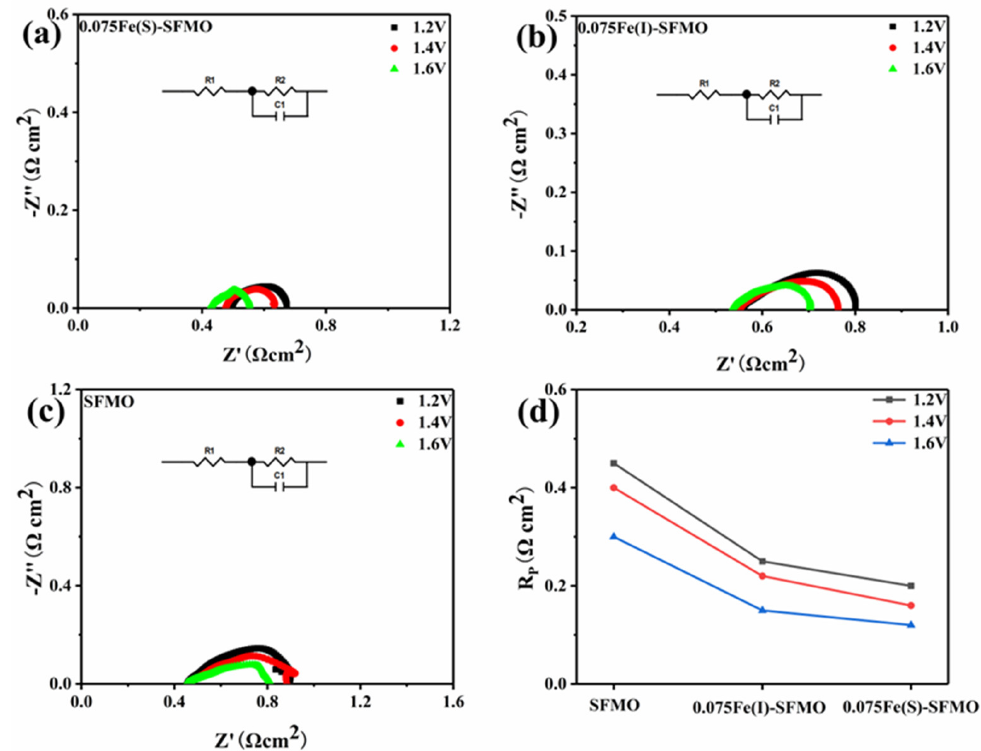
Figure 8. Electrochemical performance of SFMO materials. AC impedance spectra based on ( a ) 0.075Fe(S)-SFMO, ( b ) 0.075Fe(I)-SFMO and ( c ) SFMO. ( d ) The electrode polarizations with different anodes at 1.2–1.6 V at 850 ◦